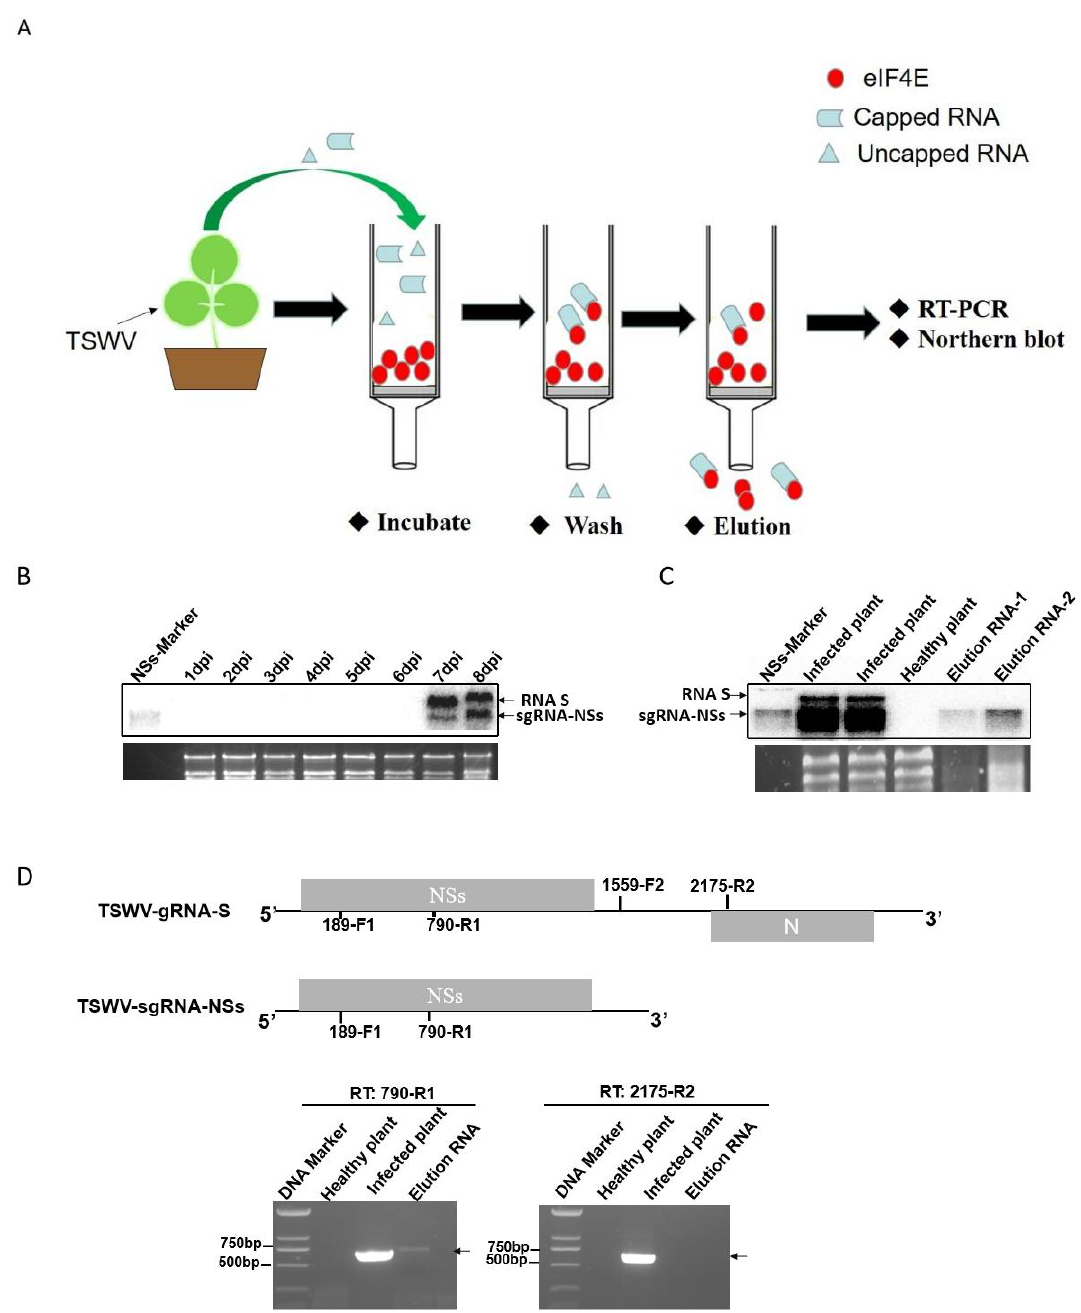
Figure 5. Enrichment of the 5 (cid:48) -capped RNAs due to high affinity for eIF4E. ( A ) 5 (cid:48) -capped RNA enrichment process. ( B ) Northern blot of total RNA isolated from TSWV-infected tobacco ( N. benthamiana ) leaves. The arrows indicate TSWV gRNA and sgRNA. ( C ) Northern blot analysis of the eluted RNA. The arrows indicate TSWV gRNA and sgRNA. ( D ) RT-PCR analysis of the eluted RNA using different primers. The arrow indicates PCR